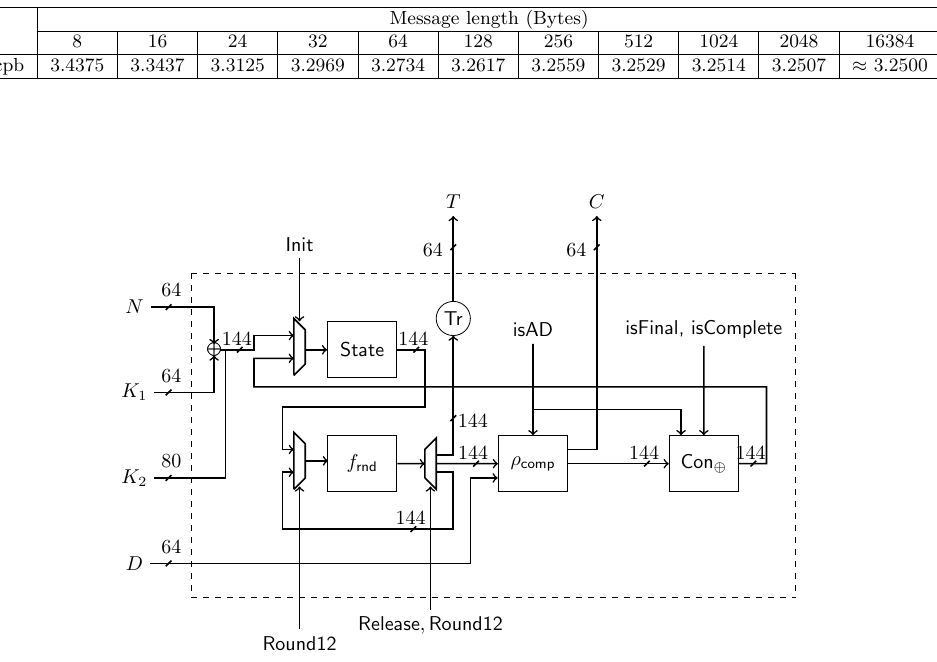
Figure 3: Hardware circuit diagram for Beetle